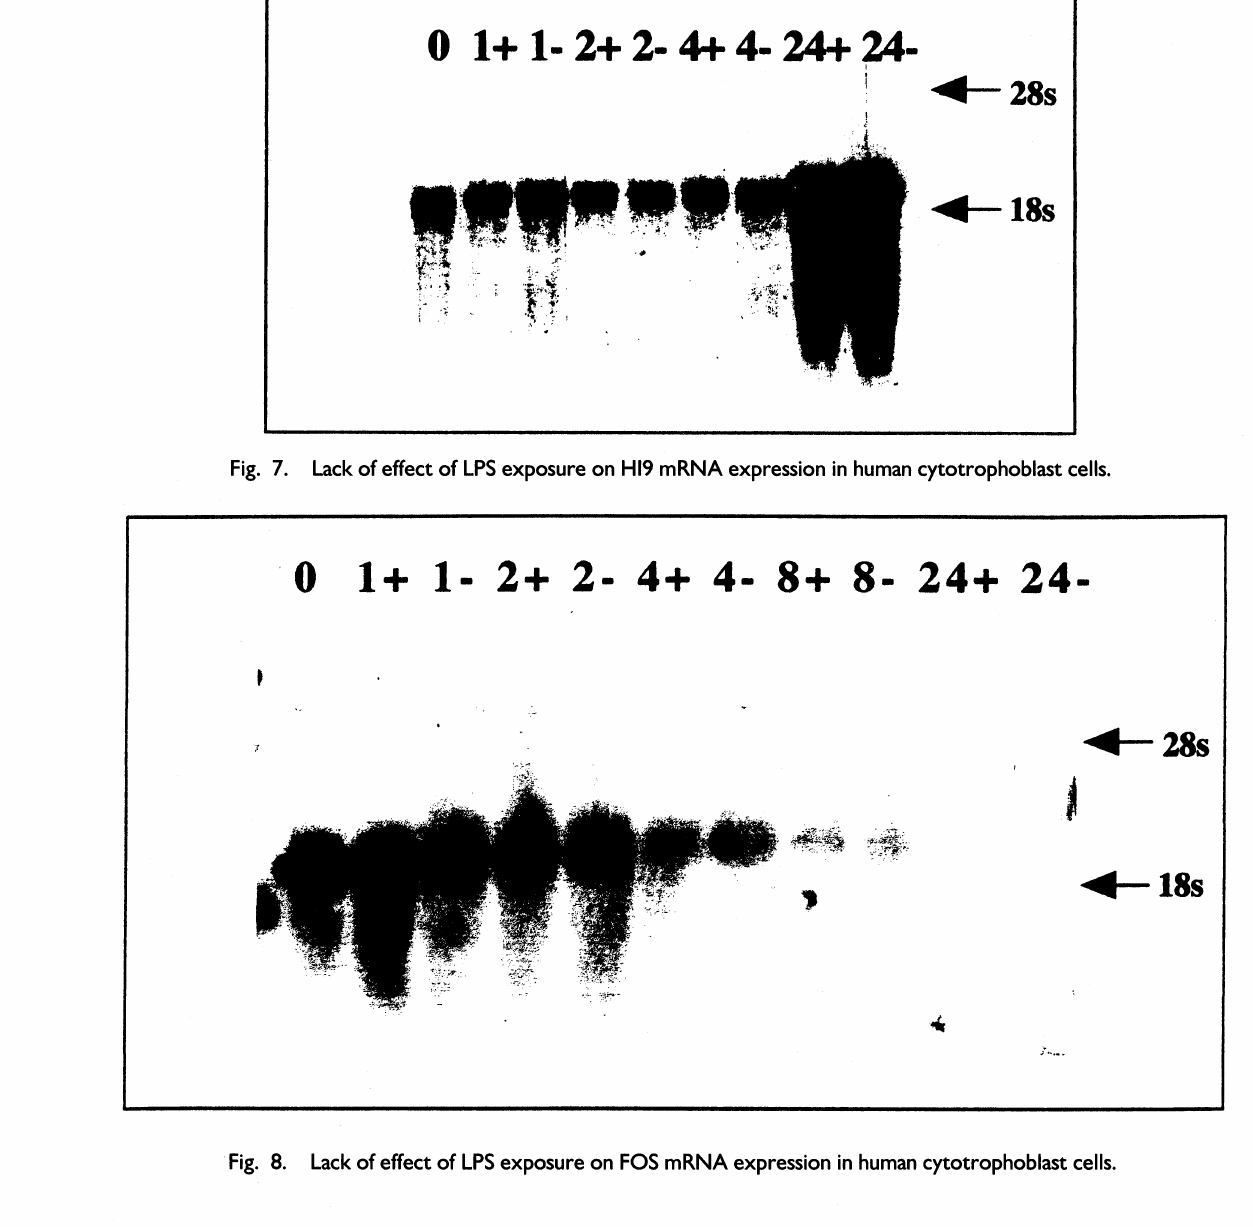
Lack of effect of LPS exposure on FOS mRNA expression in human cytotrophoblast